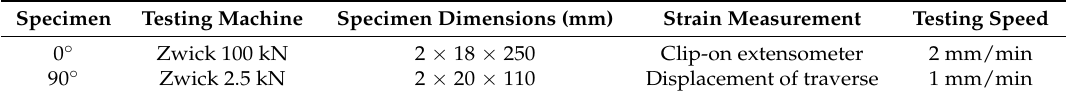
Table 2. Tensile tests